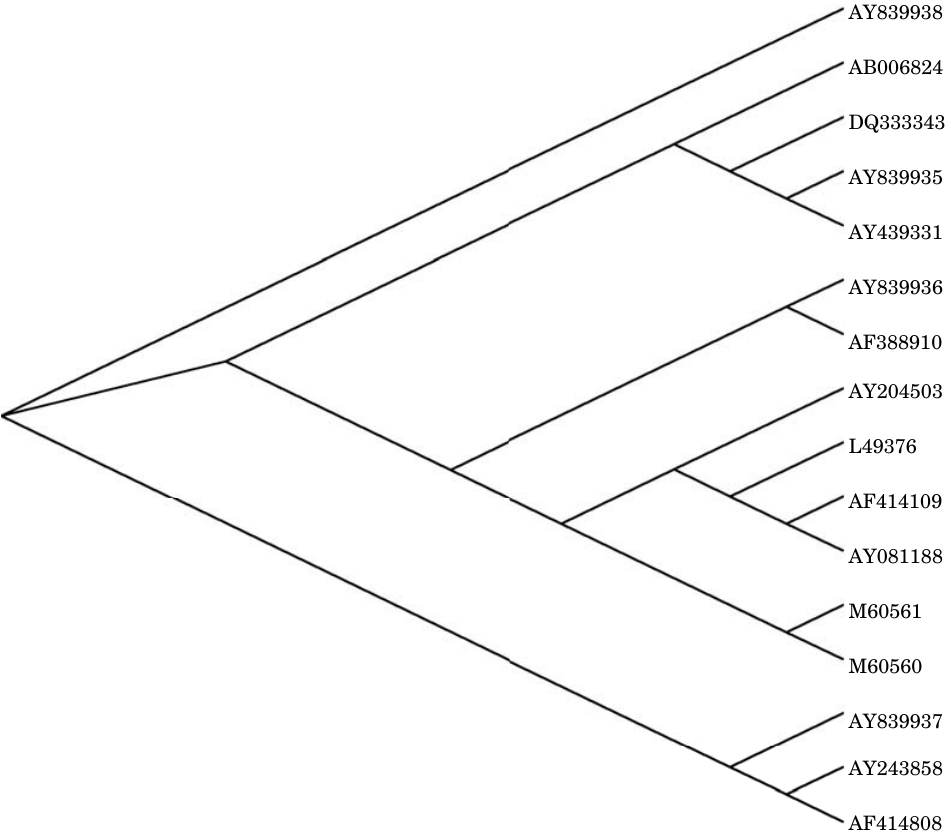
Fig. 2. UPGMA tree of the laccase gene of Ganoderma sp . isolate SV with other nucleotide sequences from